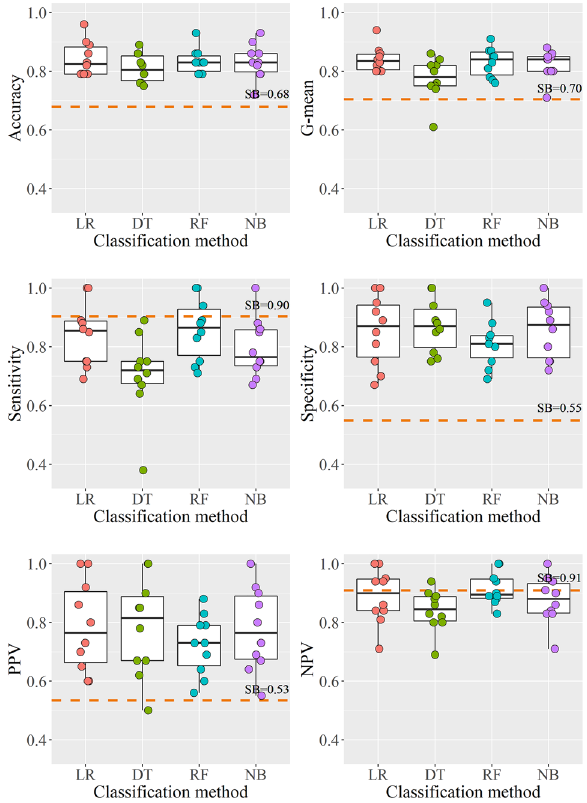
Figure 3. Tenfold cross validation results concerning the several OC, for all classification algorithms. The dashed line represents the value obtained using Simon Broome (SB) biochemical criteria. LR logistic regression, DT decision tree, RF random forest, NB Naïve Bayes.